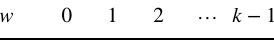
Table 2 Data for multi-choice